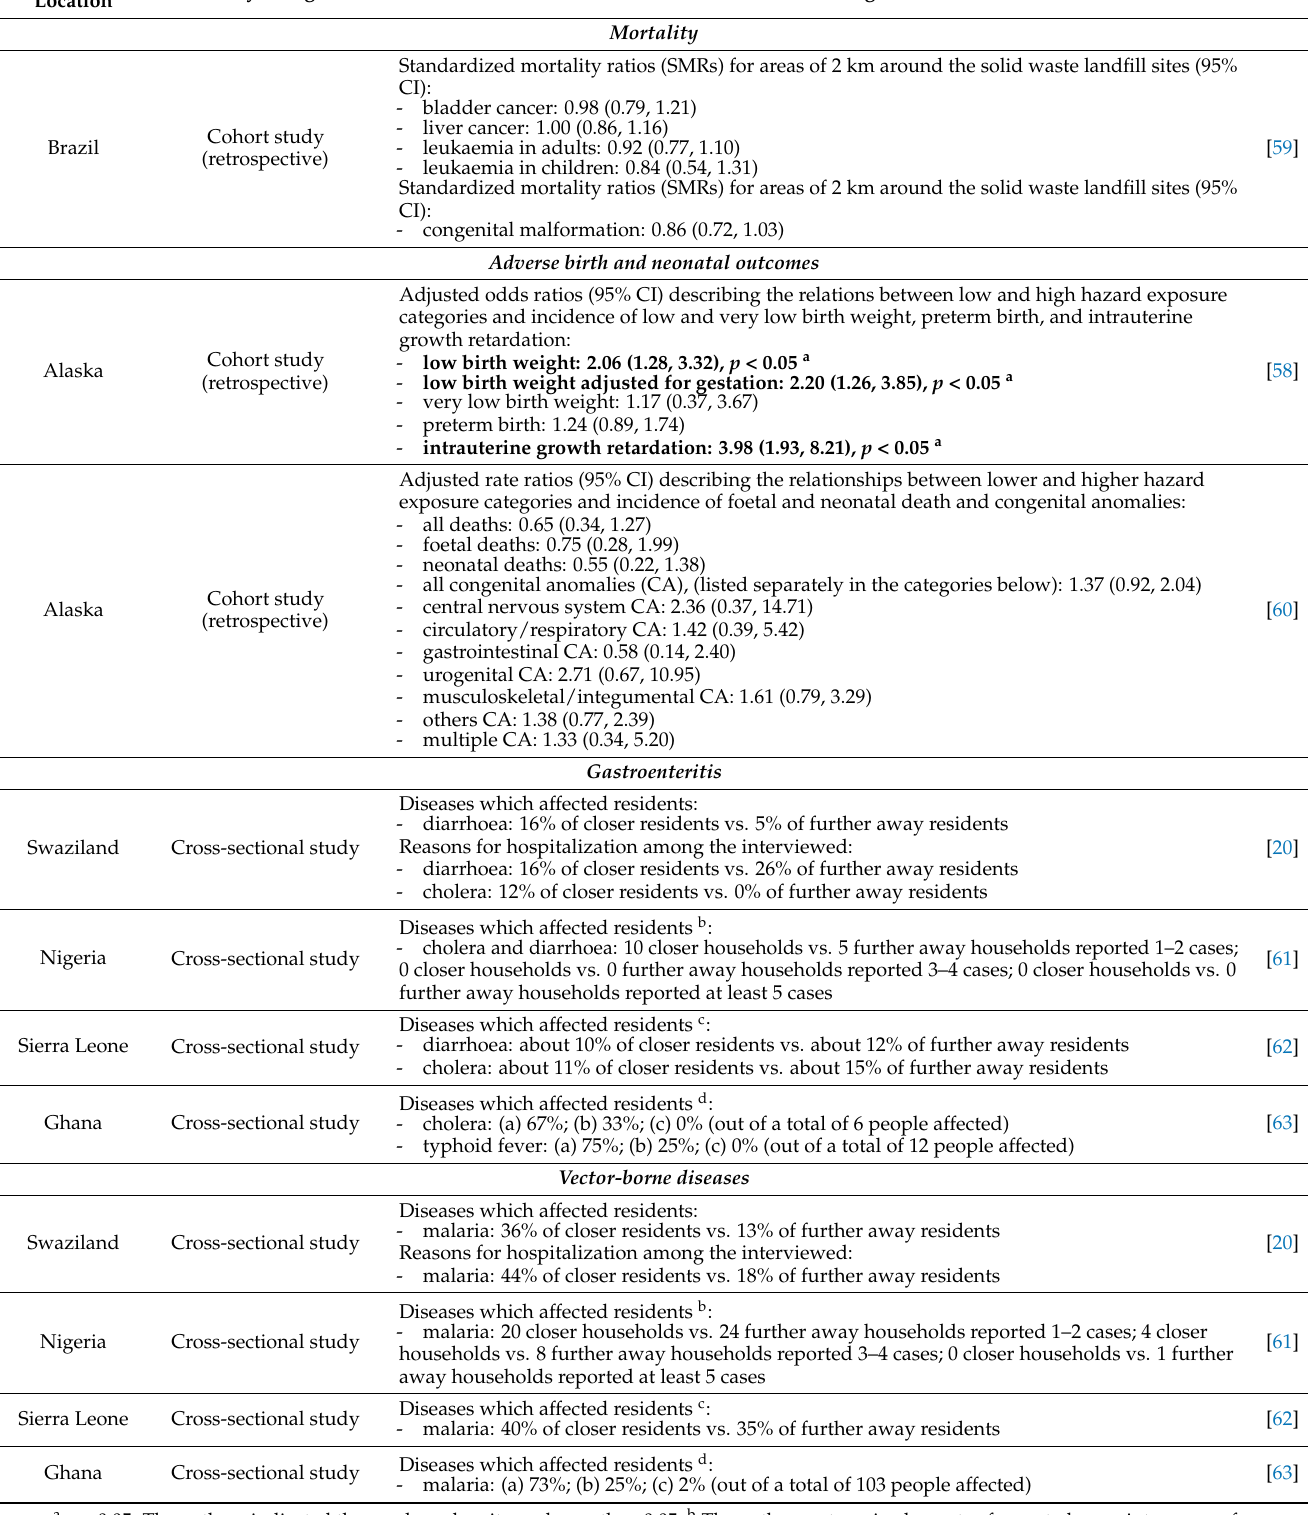
Table 6. Health outcomes associated with dumpsites and open